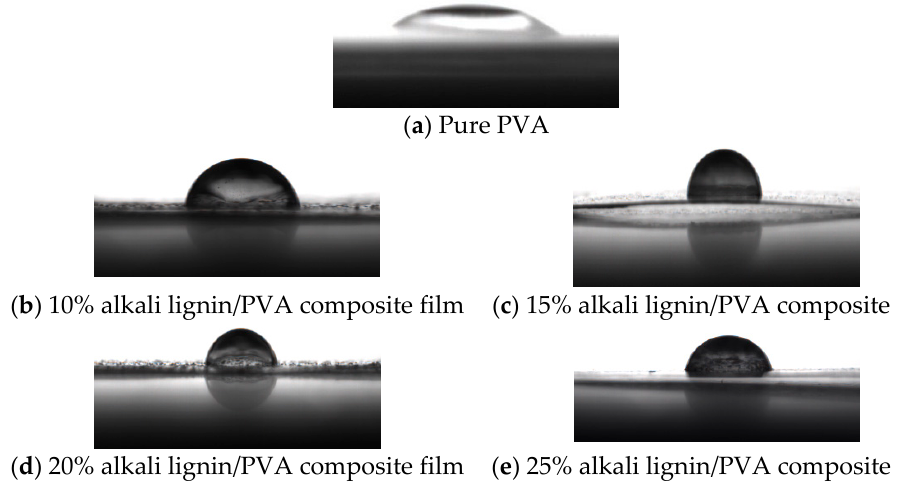
Figure 6. Contact angles of alkali lignin /PVA composite membranes.